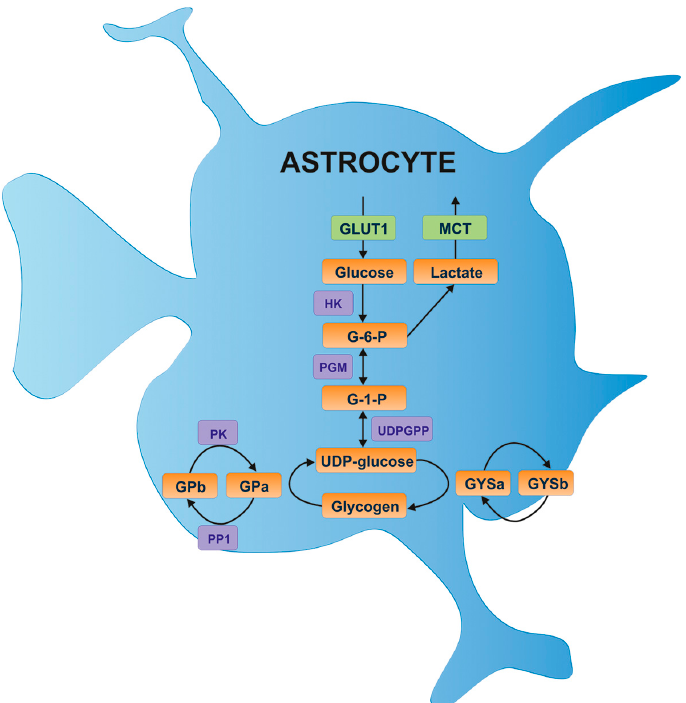
Figure 1. Glucose entry and glycogen formation in astrocytes [13]. Glucose is transported via the glucose transporter 1 (GLUT1) and possibly the insulin-sensitive glucose transporter 4 (GLUT4). Glucose is phosphorylated by hexokinase (HK) to glucose-6-phosphate (G-6-P), which is subsequently converted to glucose-1-phosphate (G-1-P) by phosphoglucomutase (PGM) and then to UDP glucose by UDP glucose pyrophosphate (UDPGPP). The UDP glucose continues on to glycogen synthesis via the actions of glycogen synthase (GYS), which can exist in two forms: the active dephosphorylated form (GYSa) or the inactive phosphorylated form (GYSb). Protein phosphatase 1 (PP1) converts GYSb to active GYSa